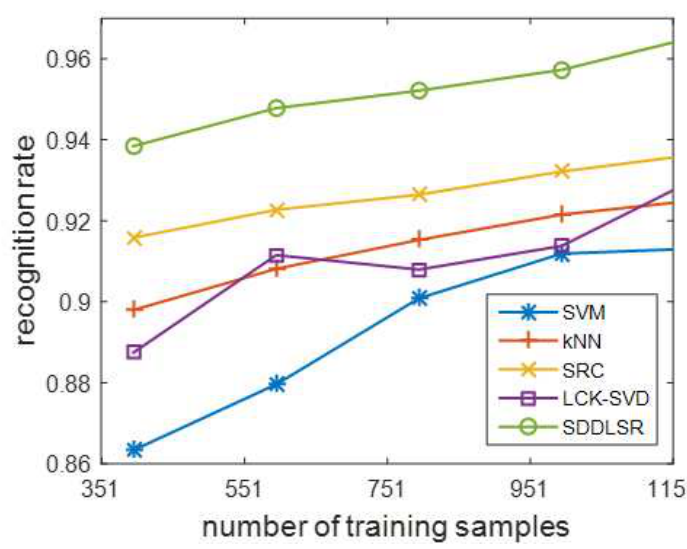
Figure 5. Recognition rates of different methods versus the training set.